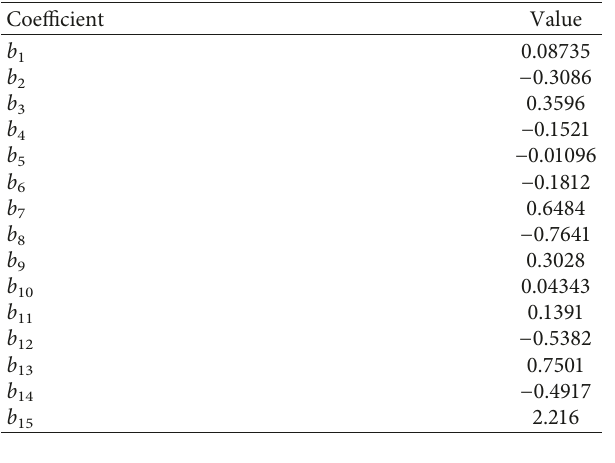
Figure 8: The three-dimensional diagram of the relationship be- tween x , E L / E S , and E T / E S Table 2: The coefficients in equation (20).